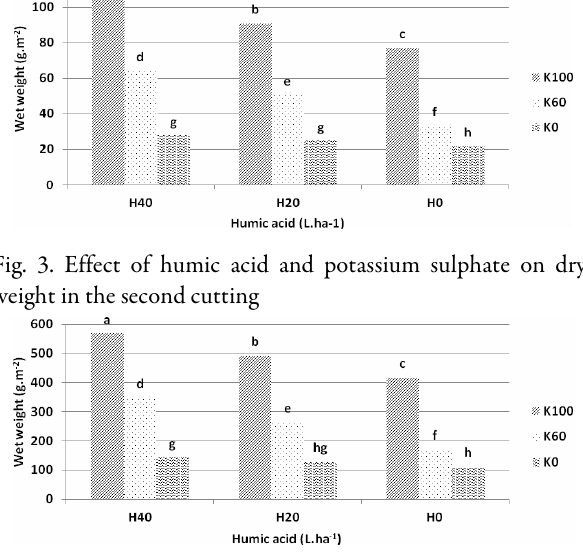
Fig. 4. Effect of humic acid and potassium sulphate on wet weight in the second cutting